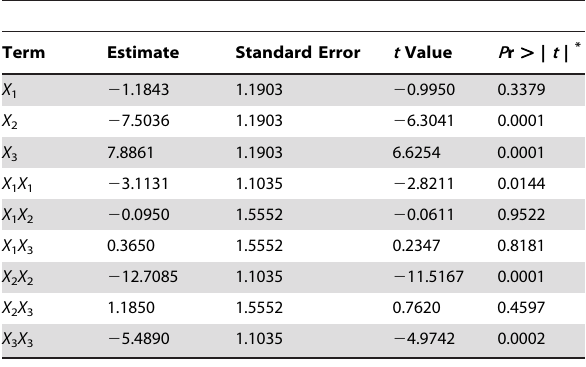
Table 4. Effect estimates for the fitted quadratic polynomial model for chlorpyrifos degradation.